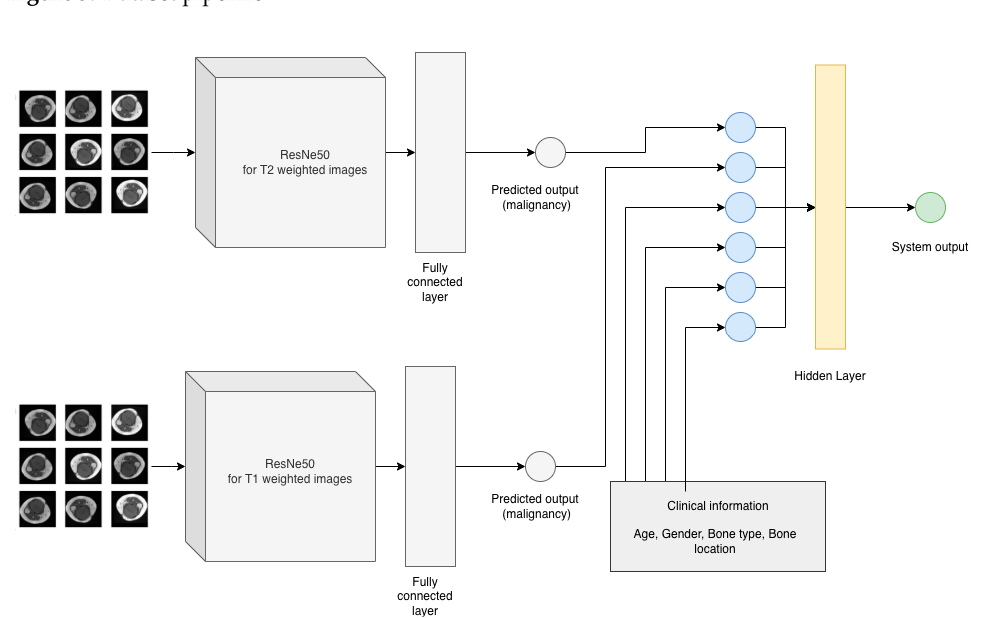
Figure 3. Dataset pipeline.